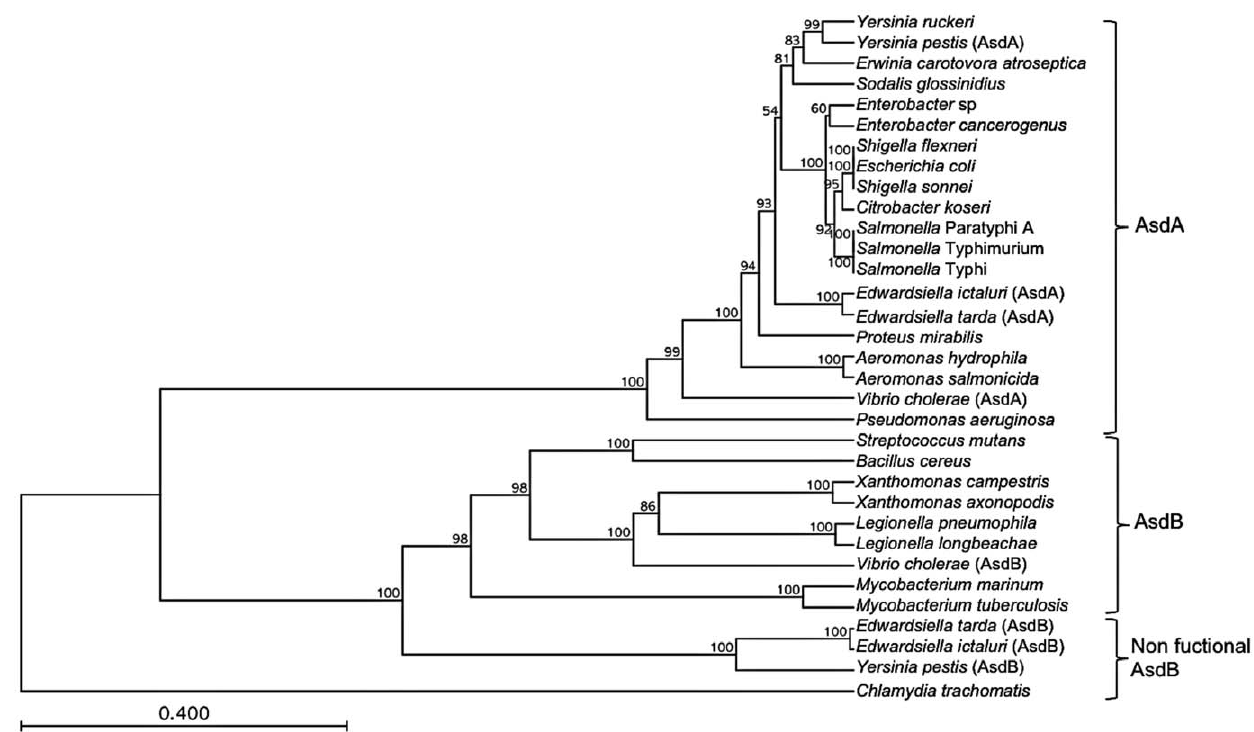
Figure 3. Phylogenetic tree constructed by the unweighted pair group method with arithmetic mean. Bootstrap values indicate the number of times that a given node was detected out of 100. The Asd sequences were obtained from NCBI’s Entrez Protein database for Edwardsiella ictaluri YP_002935083.1; Edwardsiella tarda YP_003297386.1; Escherichia coli AP_004358.1; Salmonella Typhi NP_807591.1; Salmonella Paratyphi A YP_152515.1; Salmonella Typhimurium AAB69392.1; Shigella flexnieri YP_690789.1; Shigella sonnei YP_312455.1; Citrobacter koseri YP_001456333.1; Enterobacter cancerogenus ZP_05969786.1; Enterobacter sp. YP_001178547.1; Yersinia pestis NP_671174.1; Yersinia ruckeri ZP_04615435.1; Proteus mirabilis YP_002152826.1; Aeromonas hydrophila ABK39477.1; Aeromonas salmonicida YP_001142146.1; Sodalis glossinidius YP_456010.1; Vibrio cholerae YP_002810714.1; Pseudomonas aeruginosa NP_251807.1; Erwinia carovora atrosepticum YP_052242.1; Streptococcus mutans NP_721384.1; Edwardsiella ictaluri YP_002934124; Edwardsiella tarda YP_003296462; Vibrio cholerae YP_001217630.1; Bacillus cereus YP_085142.1; Legionella longbeachae CBJ10915; Legionella pneumophila YP_096311.1; Xanthomonas axonopodis NP_643032.1; Xanthomonas campestris NP_637897.1; Mycobacterium tuberculosis NP_218225.1; Mycobacterium marinum YP_001853481.1; Chlamydia trachomatis